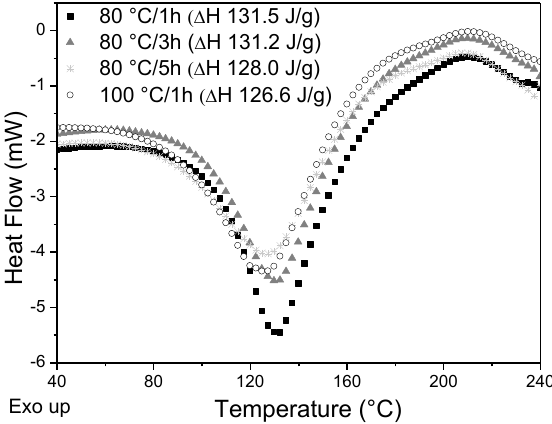
Figure 1. DSC curves for PS/S:CC 2:1 premixtures after different preheating parameters.